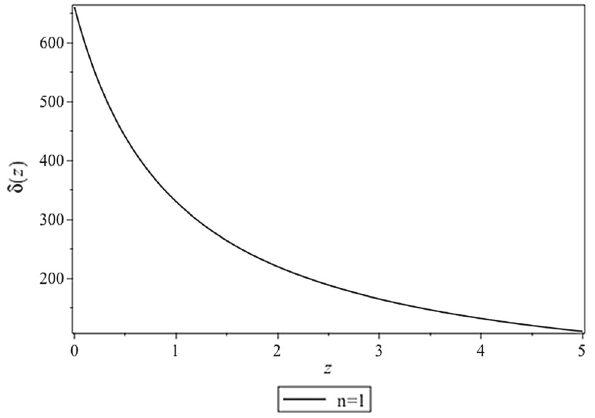
Fig. 3 The growth of the density contrast versus cosmological redshift forthepowerlaw f ( T ) gravitymodelforthefirstorderequations(133)– (138) for n = 1